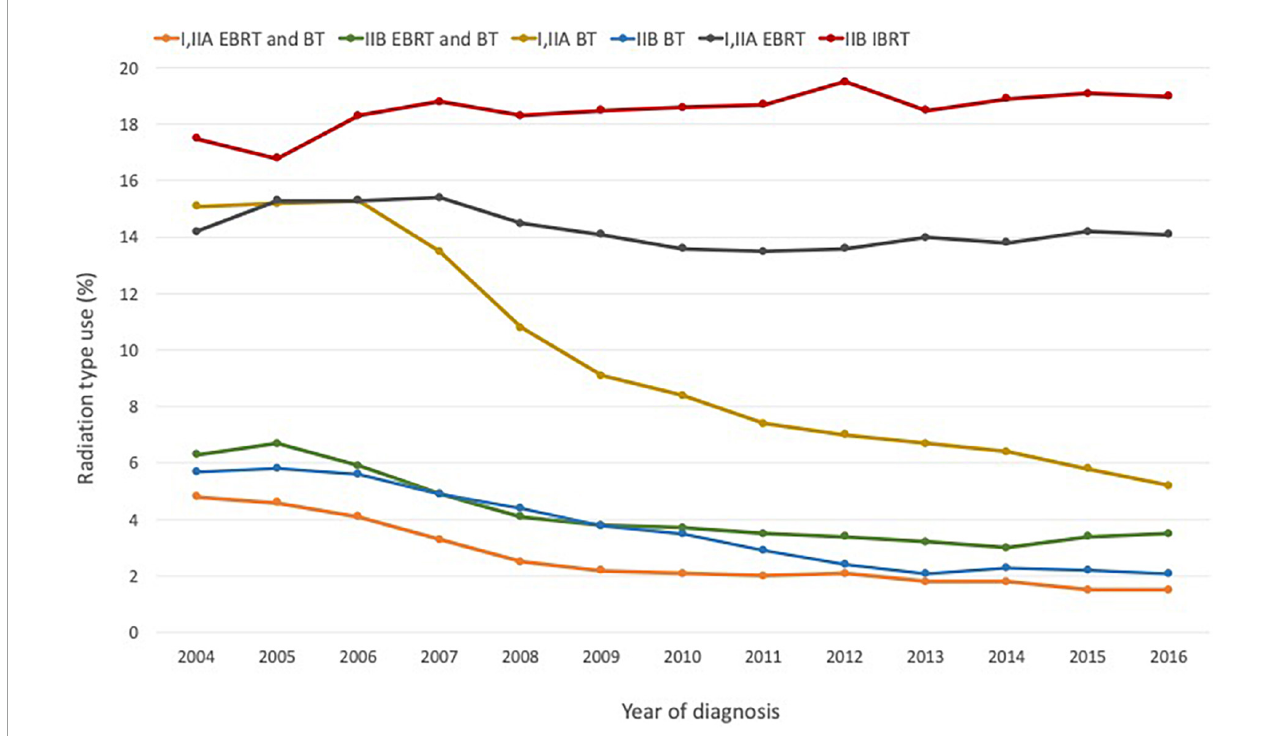
FIGURE1 Radiation modality by stage and diagnosis year for prostate cancer based on NCDB data for the period 2004–2016. Figure adapted with permission from (23),